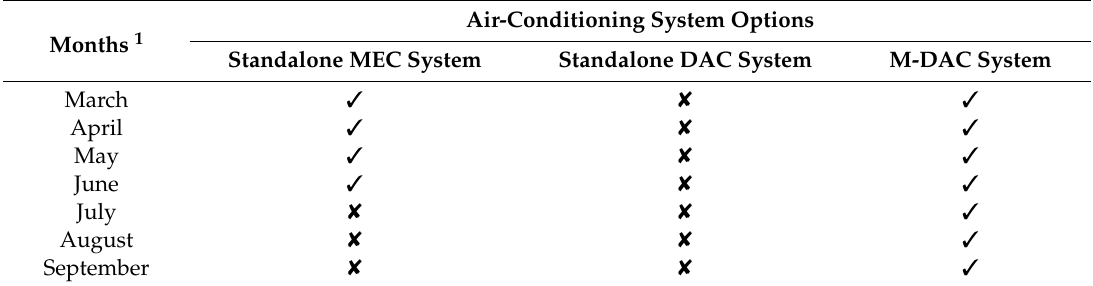
Table 3. Feasibility of proposed systems for livestock air-conditioning in Multan,